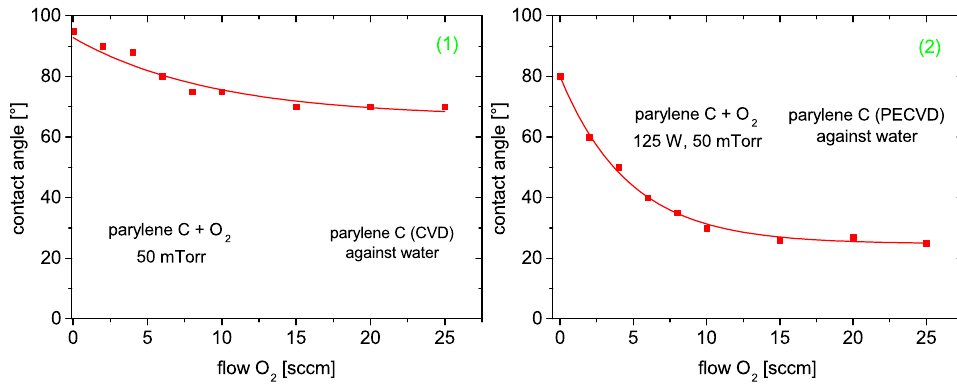
Figure 32. Contact angle of parylene C layers codeposited with oxygen with CVD ( 1 ) and PECVD ( 2 ). The tendency towards hydrophilicity is obvious.